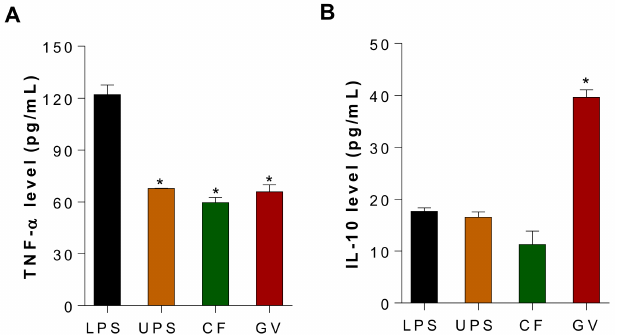
Figure 5. Effects of three seaweed extracts on TNF- α and IL-10 production in LPS-stimulated C2C12 myotubes. ( A ) TNF- α and ( B ) IL-10 production after UPS, CF, and GV treatment of C2C12 myotubes. C2C12 myotubes were pretreated with seaweed extract for 3 h, and LPS (100 ng/mL) was added for another 24 h. Data are represented as the mean ± SEM. Asterisks represent statistical significances compared with values of LPS treated group according to ANOVA ( p < 0.05). Abbreviations: LPS, Lipopolysaccharide; UPS, Undaria pinnatifida sporophyll; CF, Codium fragile ; G V , Gracilaria